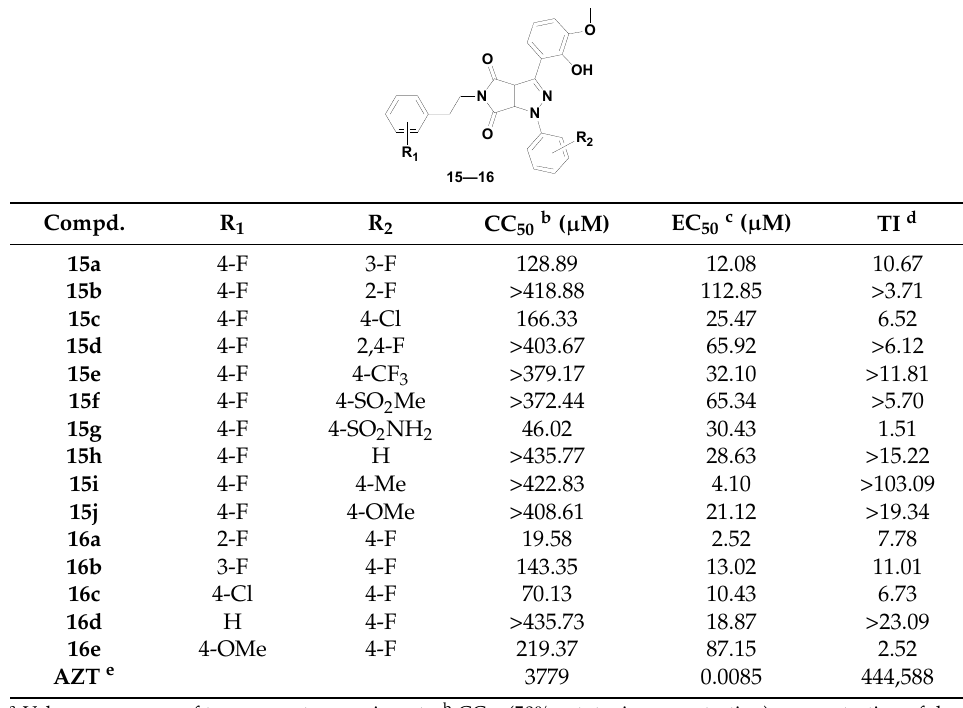
Table 2. Anti-HIV activity of compounds 15 – 16 in vitro a .